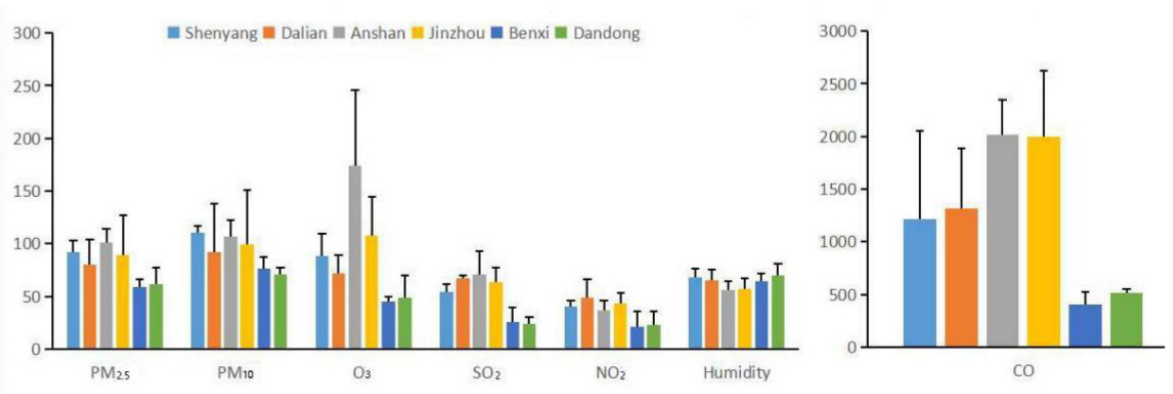
Figure 2. Air pollution concentrations ( μ g/m 3 ) and humidity (%) in the six cities of Liaoning, China, from 2012 to 2014. Table 2. Characteristics of taxi drivers with or without DED ( n =